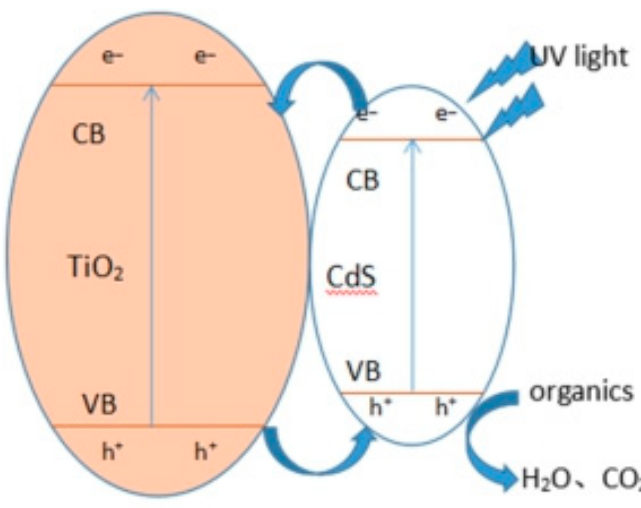
Figure 10. Mechanism of photodegradation.